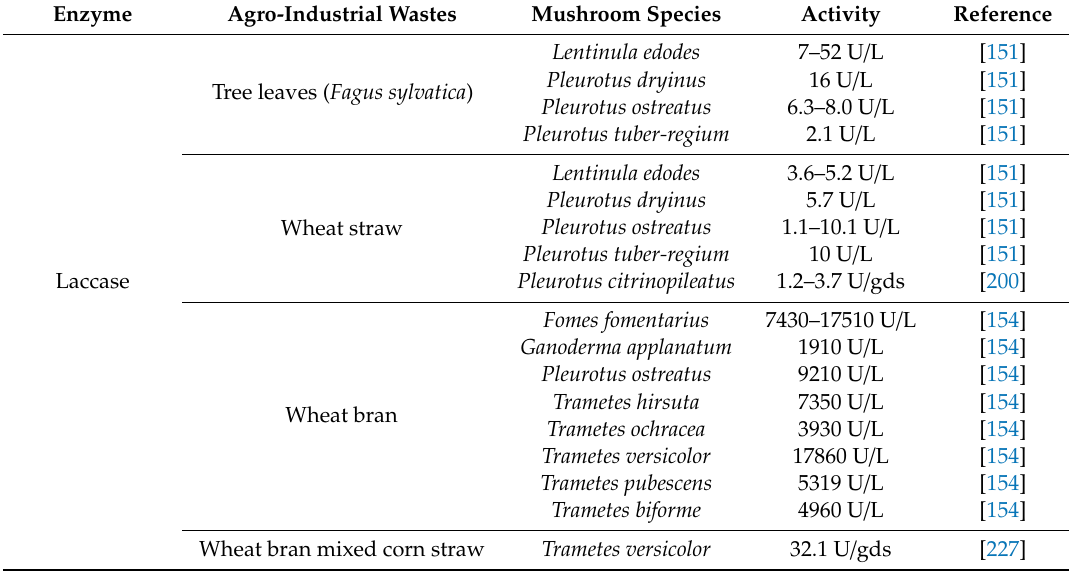
Table 7. Production of enzymes in solid state fermentation of lignin degradation by some mushrooms using agro-industrial